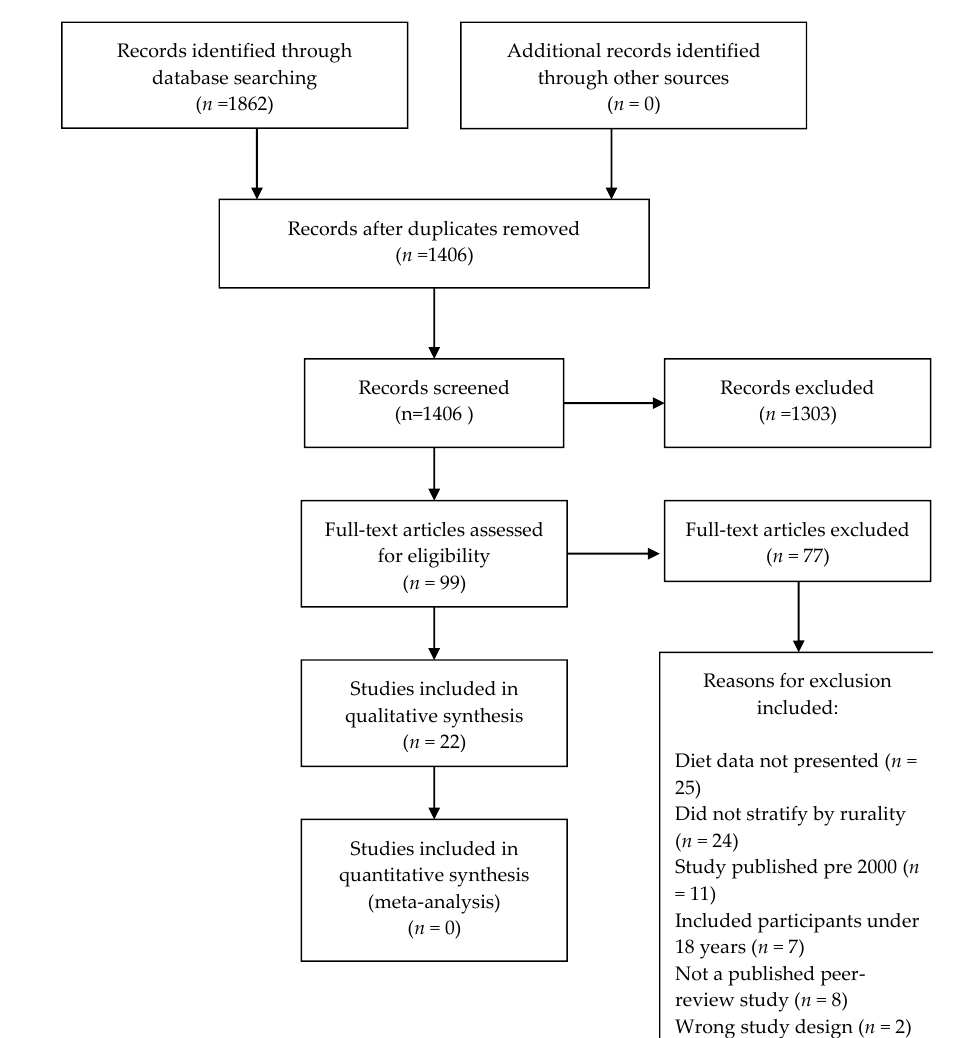
Figure 1. PRISMA flow diagram of included studies.